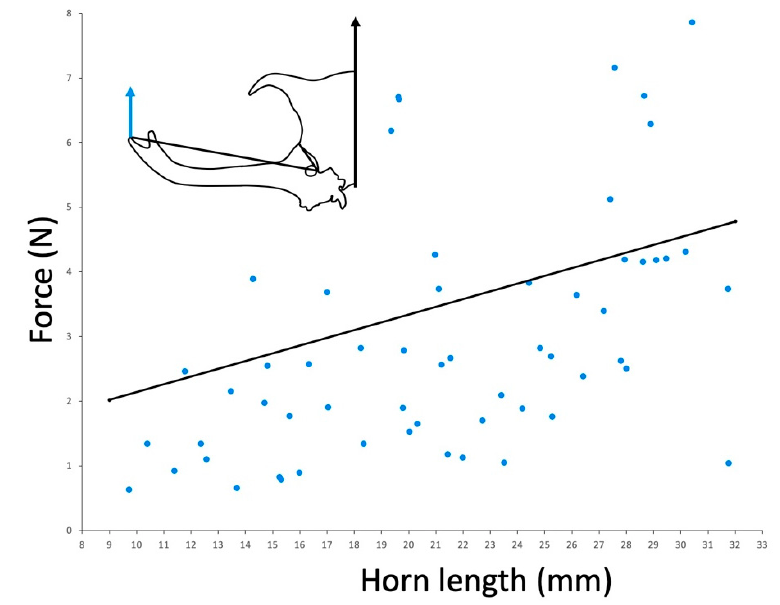
Figure 3. Relationship between measured force (blue arrow in inset) and horn length in the Taiwan population. The black line represents the empirical relationship found between horn length and the force required to pull a beetle off of a tree (black arrow in inset, from [14]).